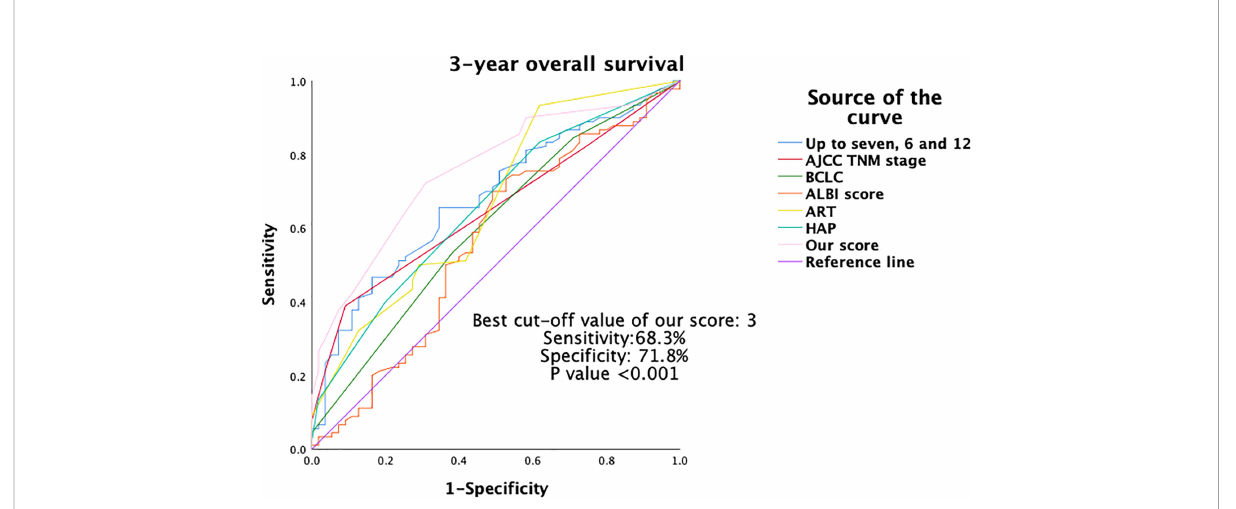
FIGURE 4 Area under the ROC (AUROC) of 3-year OS of different scoring systems. OS, overall survival; ROC, receiver operating